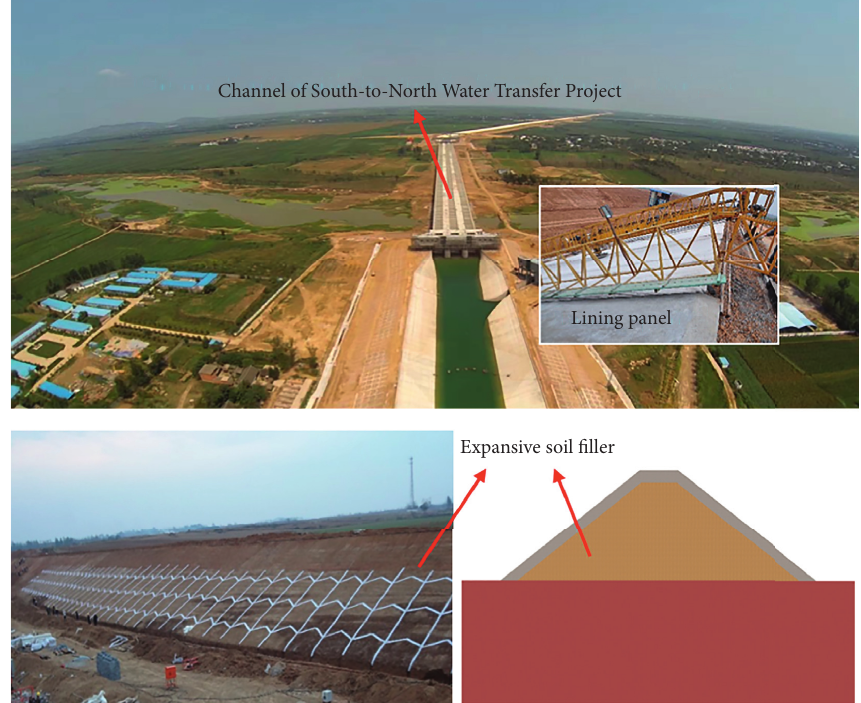
Figure 2: Expansive soil filler of high-fill channel in the Nanyang section of the South-to-North Water Transfer